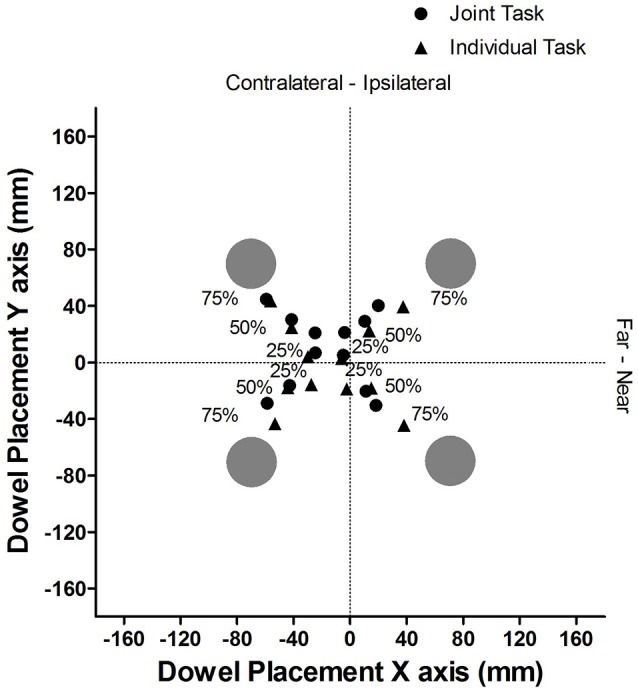
Experiment 2: Mean dowel placement in absolute coordinates for each cue validity and task condition.